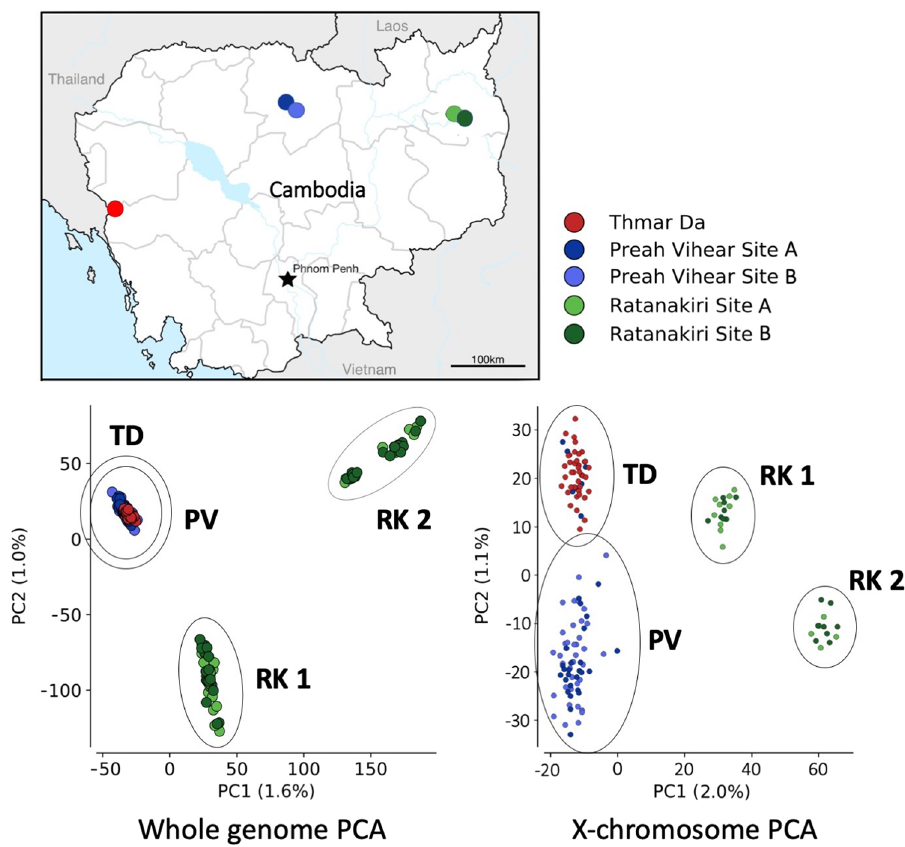
Fig. 1 Population structure of An. minimus in Cambodia. The map indicates the fi ve Cambodian collection sites. Principal component analysis (PCA) of whole genome sequences of 283 individual An. minimus s.s . collected in fi ve villages in Cambodia shows that there is a distinct population structure and three populations. When performing the same PCA on a large X-chromosomal contig (KB664054), these individuals break into four populations: TD from the West, PV from the northern province in Preah Vihear, and RK1 and RK2, both collected in two sites in Ratanakiri province in the